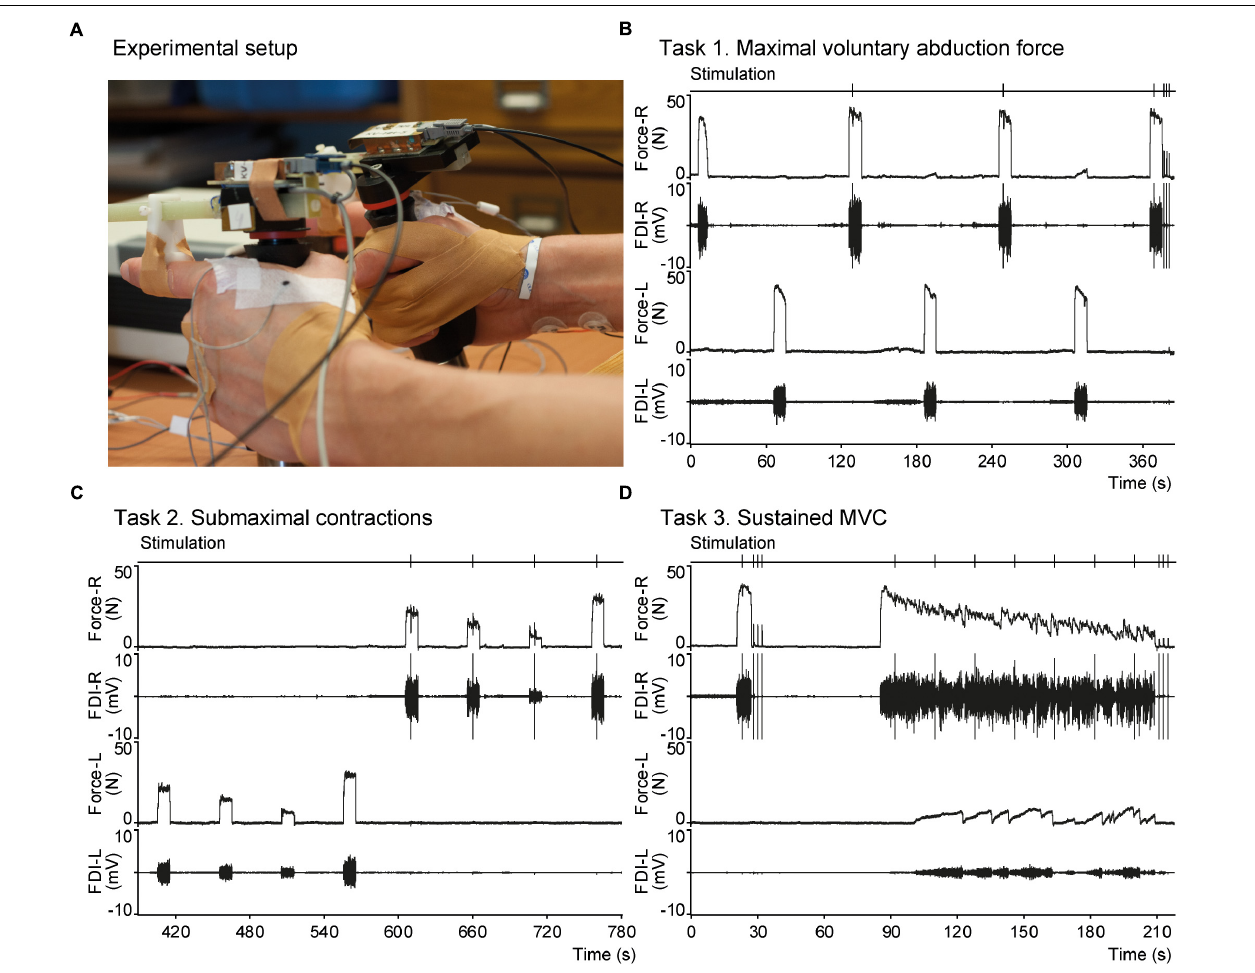
FIGURE 1 | Experimental setup and an example of raw data. (A) Photograph showing the hands a participant equipped with force transducers. The finger bracket is positioned over the proximal interphalangeal joint of the index fingers as can be seen for the left hand. Placement of EMG electrodes over the FDI can be seen for the left hand and electrodes used for electrical stimulation can be seen on the right wrist. (B–D) Panels showing raw data recorded in a male mTBI participant during tasks 1–3, respectively. From top to bottom each panel shows the time-points of electrical nerve stimulation, index finger abduction force of the right hand, EMG of the right FDI, force of the left hand, and EMG of the left FDI. MVC, maximal voluntary contraction; FDI, first dorsal